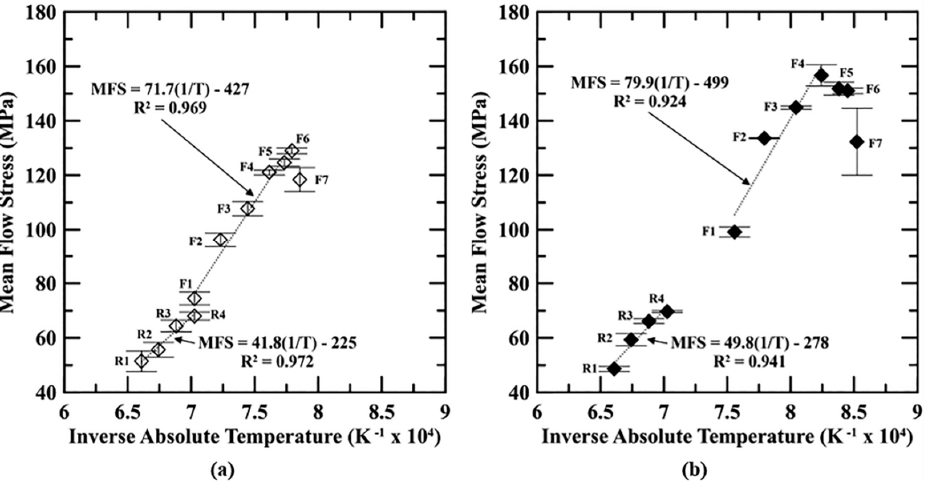
Figure 8. Summary of mean flow stress as a function of inverse absolute temperature for ( a ) High T Finish and ( b ) Low T Finish simulations via hot torsion testing. Two linear regressions are included in each figure: the first for the roughing stage (R) and the second for the finishing stage (F), excluding the softening region. The error bars represent one standard deviation.